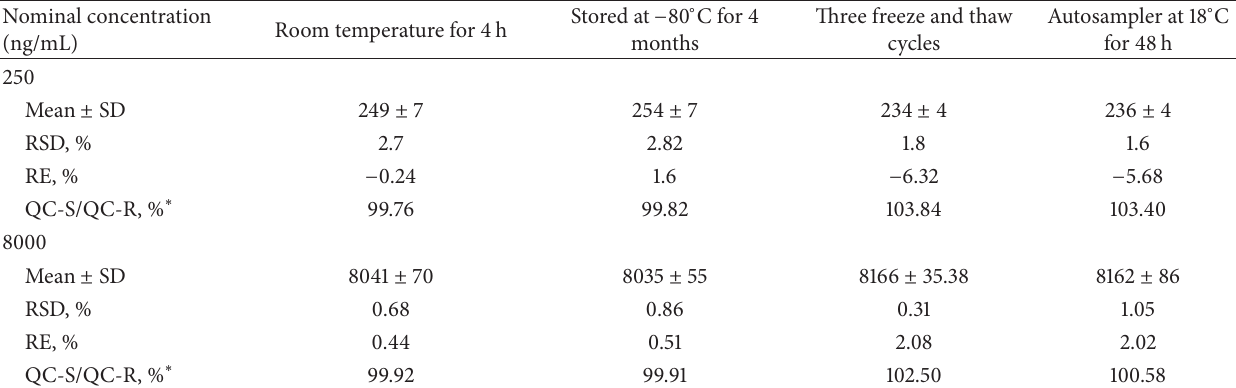
Table 2: Stability of FLC assay in C. albicans biological matrix.